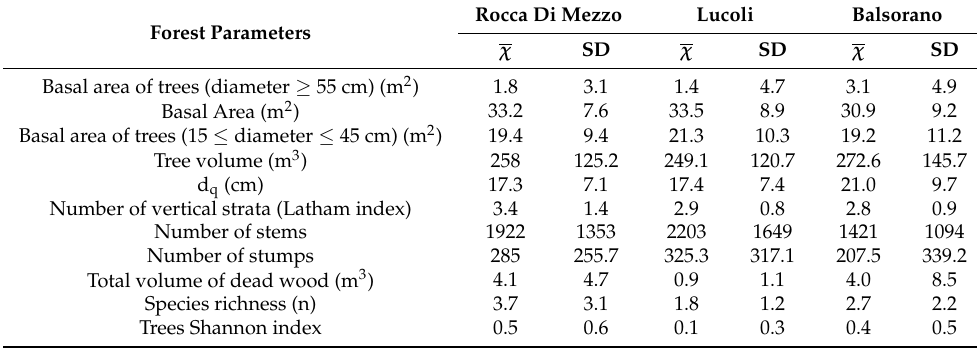
Figure 1. Location of the study area in central Italy and the distribution of plots in the three macro areas to test the effect of forest structure and topography on abundance of key foods for Apennine brown bears. Bear range extracted from [19]. Table 1. Forest parameters estimated (mean and standard deviation (SD)) for each sampled area to test the effect of forest structure on abundance of key foods for Apennine brown